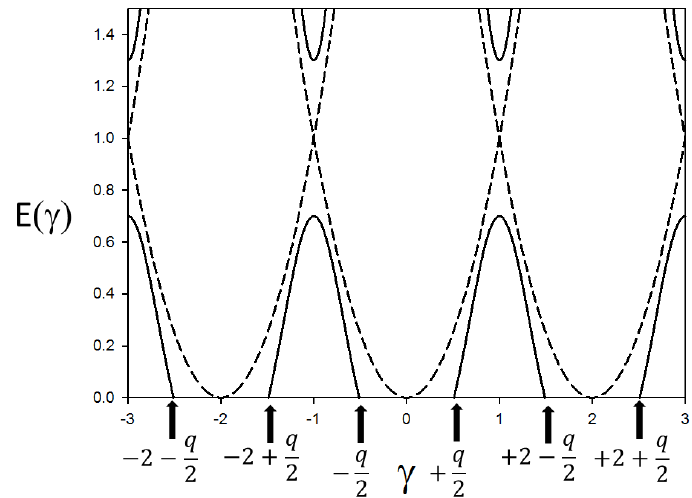
Figure 1. Schematic illustration of the band diagram for Floquet solutions of Mathieu’s equation (Equation (4)) in the first and second temporal Brillouin zones in absence of periodic potential, 𝐸 = 𝛾 02 (dashed curves) and with a periodic potential (solid curves). The arrows mark approximate ground state solutions of the periodically driven bubble. The interval [ − 1,1 ] constitutes the Brillouin zone in the frequency domain.